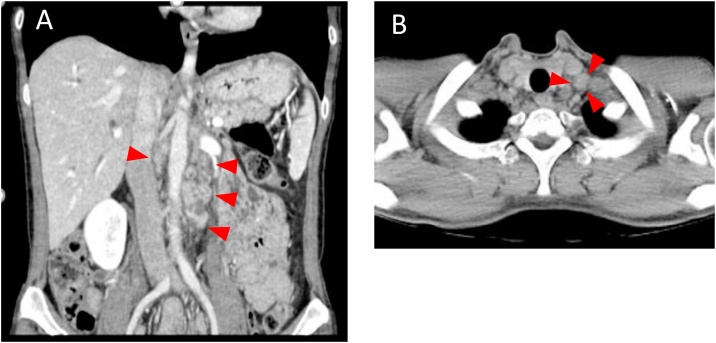
Computed tomography (CT) scan showing swellings of distant lymph nodes (red arrow heads). A: para-aortic lymph nodes (red arrow heads); B: left supraclavicular node (red arrow heads).